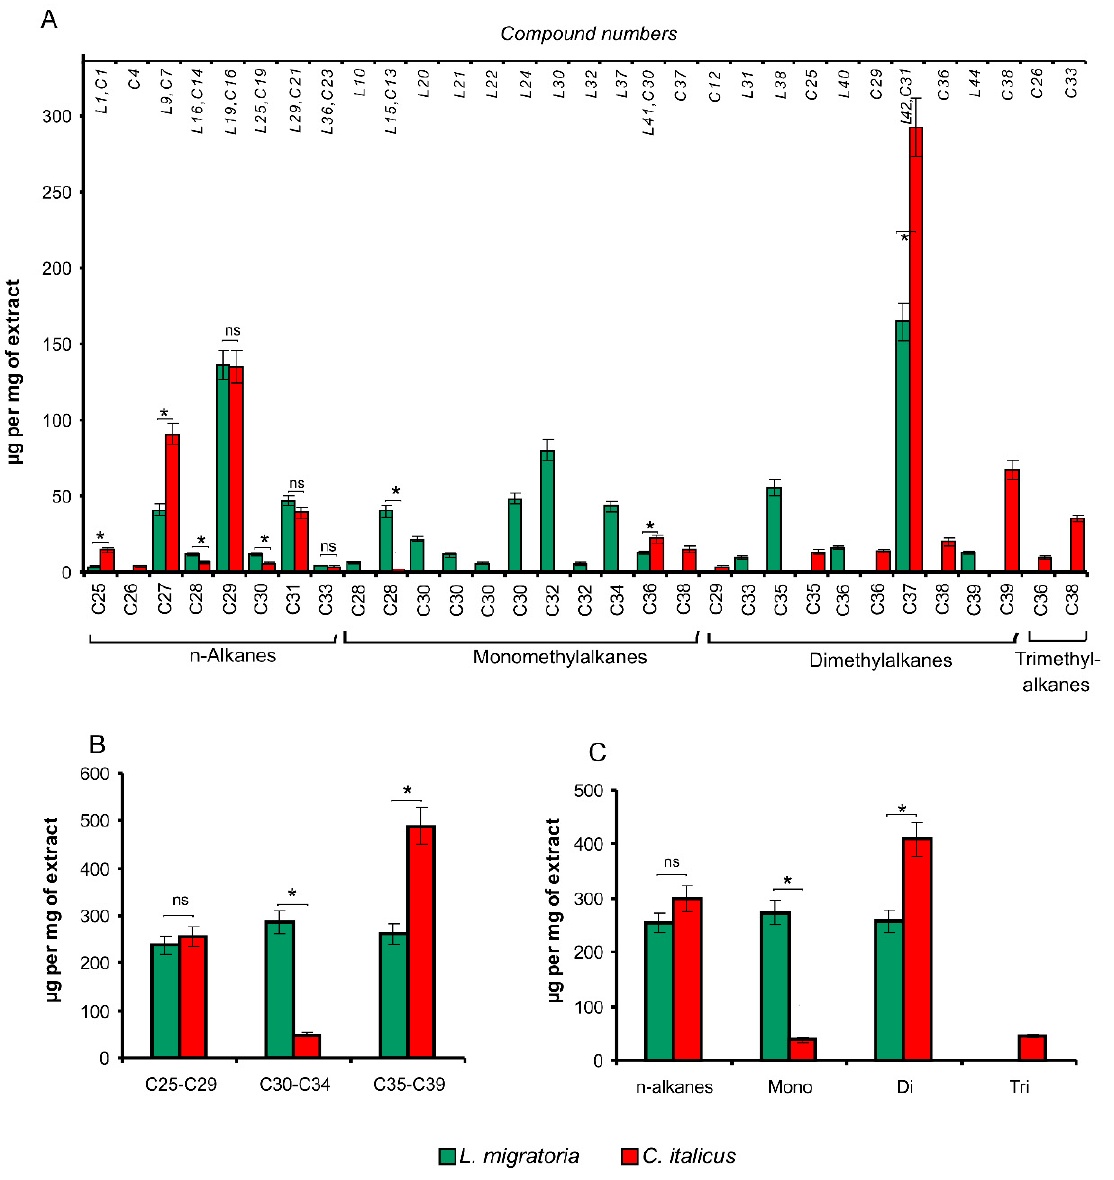
Figure 2. Hydrocarbon composition of epicuticular extracts from L. migratoria and C. italicus nymphs. ( A ) . The distribution of individual hydrocarbons. The lower x -axis indicates the total carbon number, and the upper x -axis presents numbers of compounds in L. migratoria ( L ) and C. italicus ( C ) corresponding to Tables S2 and S3. ( B ). The carbon number distribution. ( C ) . The distribution of methyl branches. * Significant differences between the species ( t -test, p < 0.05, or Mann–Whitney U test, p < 0.05); ns: nonsignificant differences.